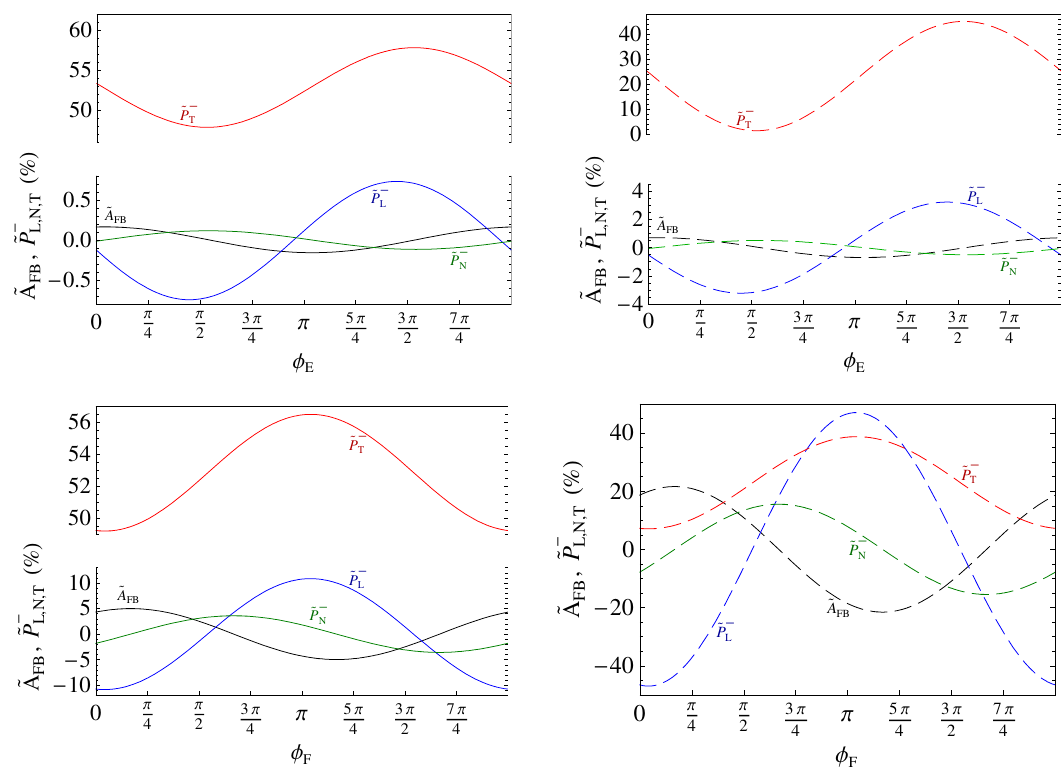
Figure 4 . The integrated asymmetries ~ A FB and ~ P (cid:0) of the muon in (cid:6) + ! p(cid:22) + (cid:22) (cid:0) versus L ; N ; T the phases (cid:30) e of the NP contributions to the coe(cid:14)cients ~ e (top plots) and ~ f (bottom plots), ; f respectively, in the decay amplitude. For the top plots, only ~ e has the NP term with magnitude g e = 7 (cid:2) 10 (cid:0) 9 GeV (cid:0) 2 (left) and 7 (cid:2) 10 (cid:0) 8 GeV (cid:0) 2 (right). For the bottom plots, only ~ f has the NP term with magnitude g f = 1 (cid:2) 10 (cid:0) 8 GeV (cid:0) 2 (left) and 1 (cid:2) 10 (cid:0) 7 GeV (cid:0) 2 (right).